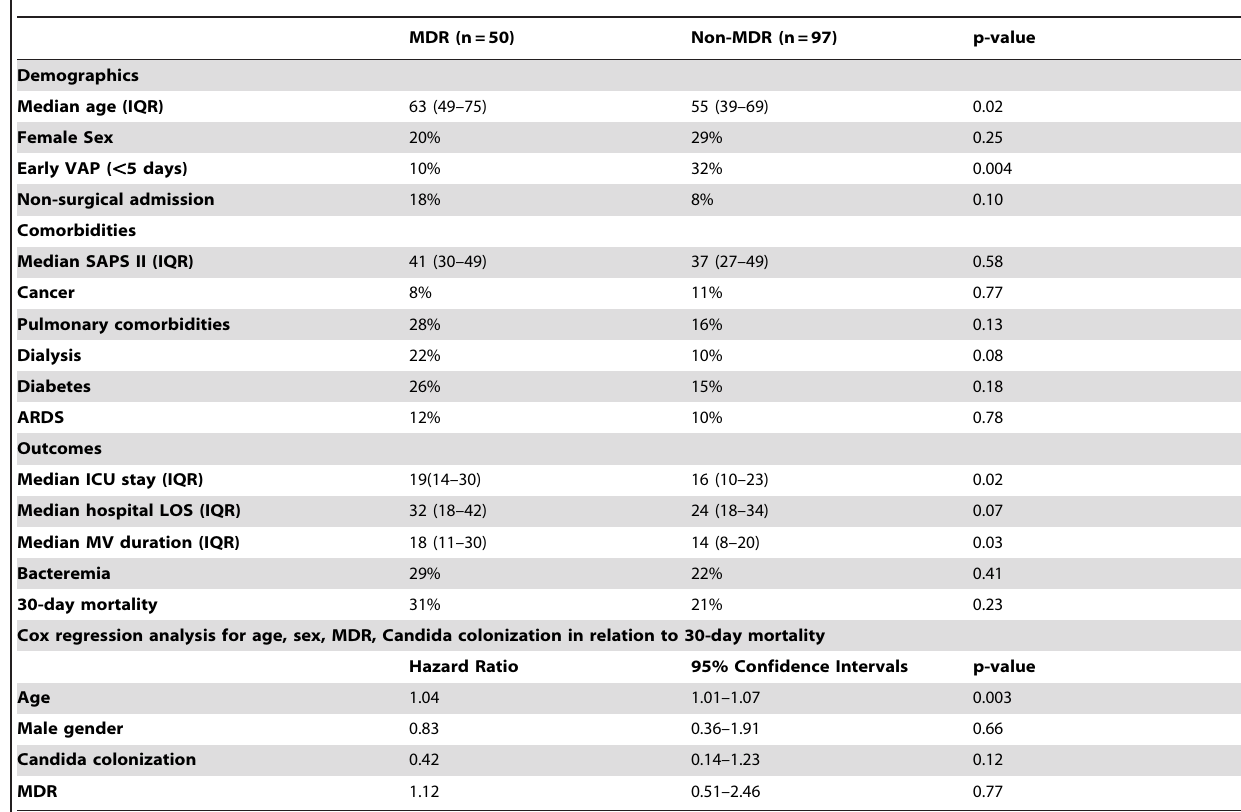
Table 2. Characteristics of MDR vs non-MDR patients with